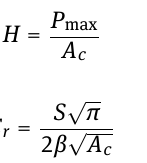
as A = 24.5 h 2 . c c c